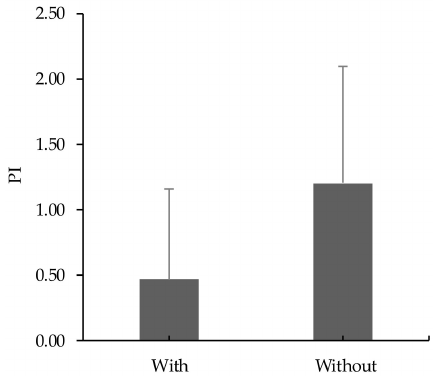
Figure 3. Mean values of perceived postural instability with and without wearing the aid. Error bars represent standard deviation